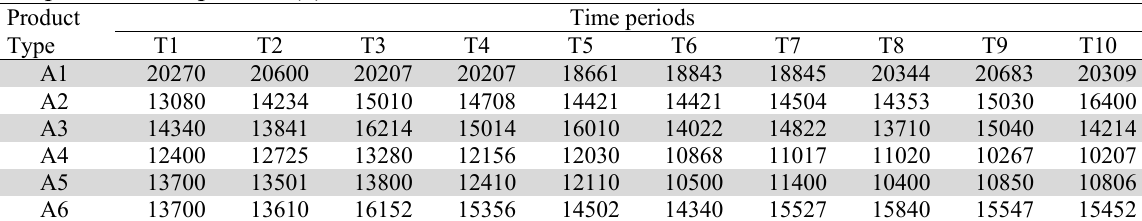
The price of final product